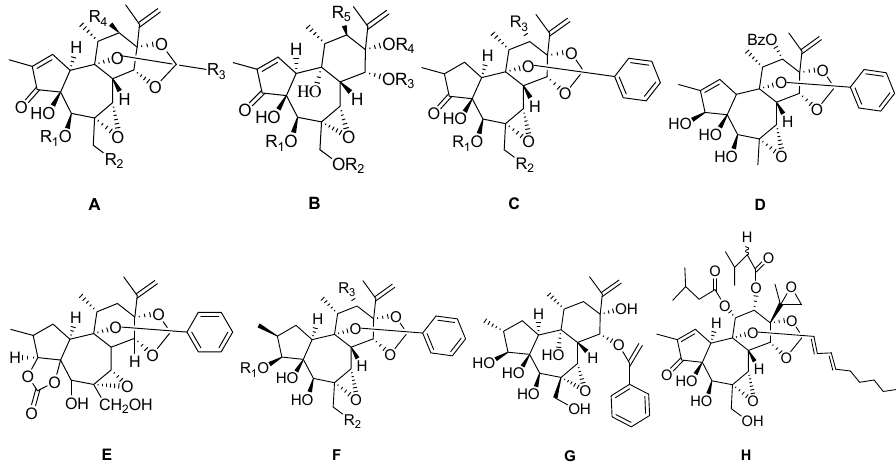
Figure 2. Eight types ( A – H ) of 6-epoxy daphnane skeletons. Table 2. Reported structures of 6-epoxy daphnane skeletons.